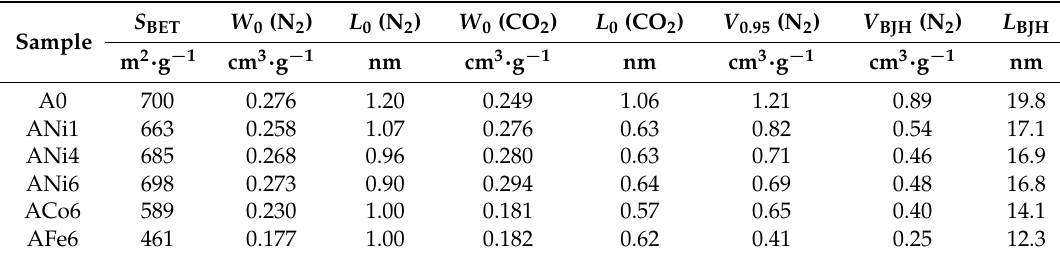
Table 1. Name, surface areas and pore volumes of the doped carbon